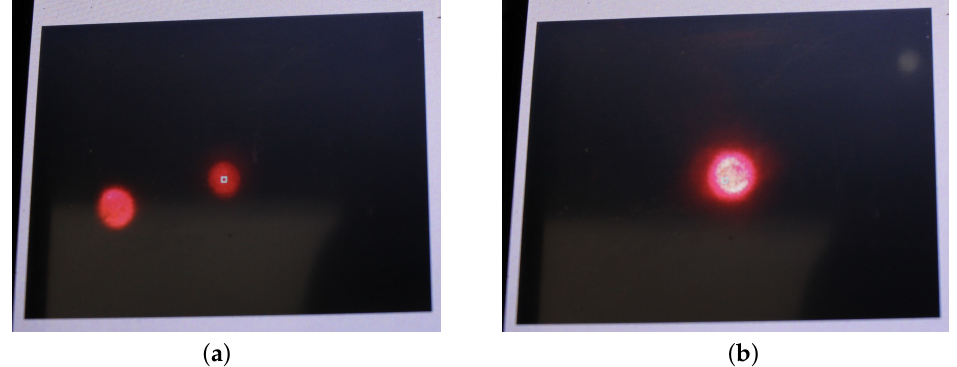
Figure 17. The photograph of the auto-collimator output at the display during operation: ( a ) the misaligned laser beams giving two spots; ( b ) aligned (i.e., collimated) laser beams giving one brighter